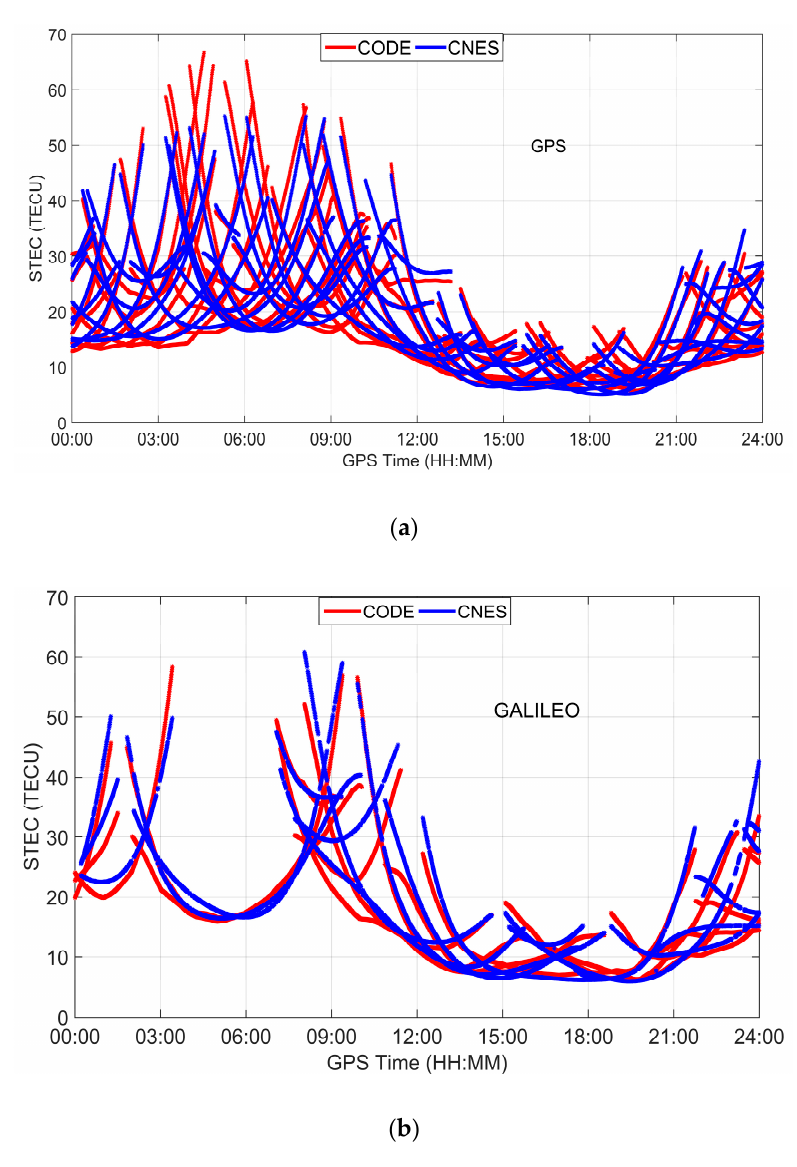
Figure 1. Slant TEC of GPS ( a ) and GALILEO ( b ) derived from different agencies at station GMSD.